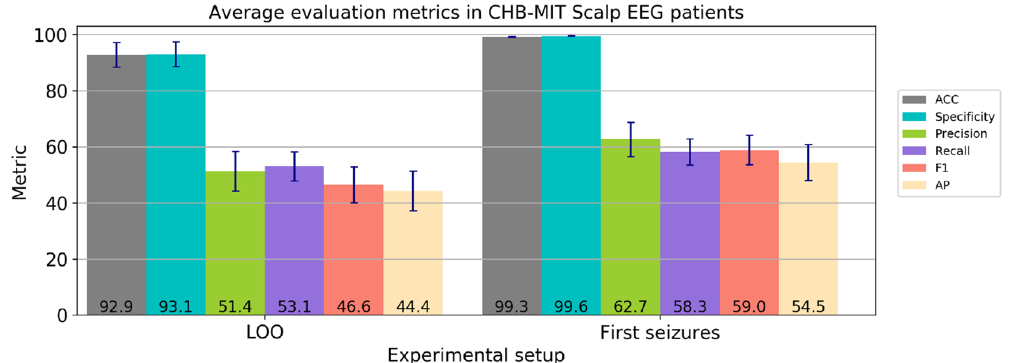
Figure 1. Average metrics for the LOO and First Seizures models evaluated in the CHB-MIT Scalp EEG √ database. Each color bar corresponds to a different metric, with the average value at the bottom and the standard N ) as blue error of the mean ( σ/